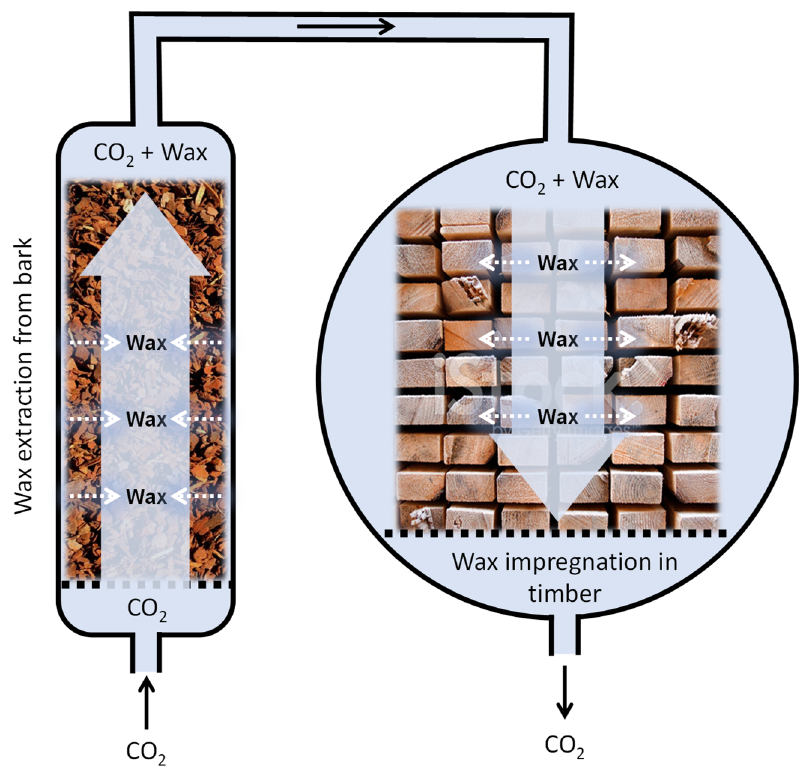
Figure 1. Conceptual representation of a hypothetical scCO 2 process that extracts wax from bark and impregnates it in timber.